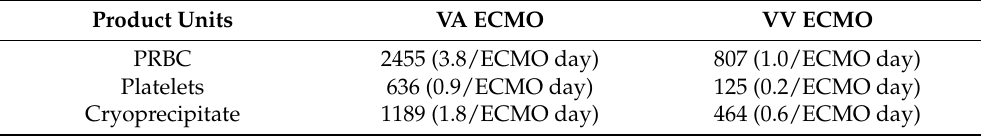
Table 5. Total number of transfused blood products in VA and VV ECMO